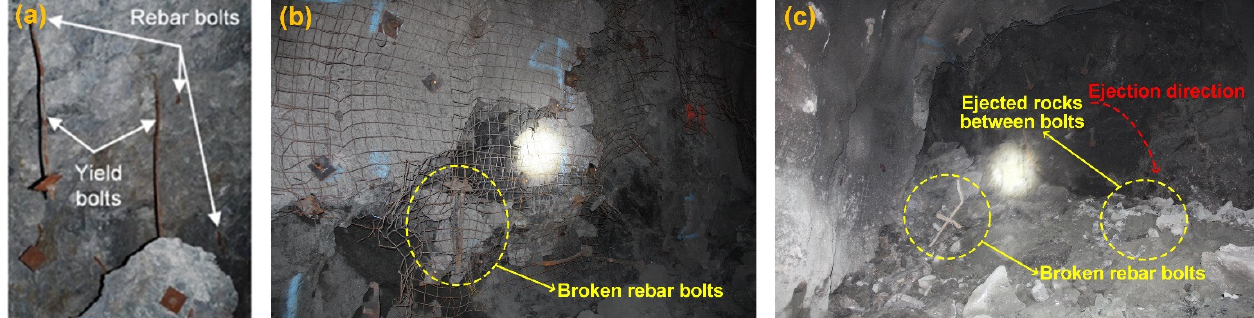
Figure 14. ( a ) Observed performance of fully resin-grouted rebar and yielding rockbolts in a rock- burst [67]. ( b , c ) are in situ observations of broken rebar bolts after rockbursts in deep tunnels (photographs taken by